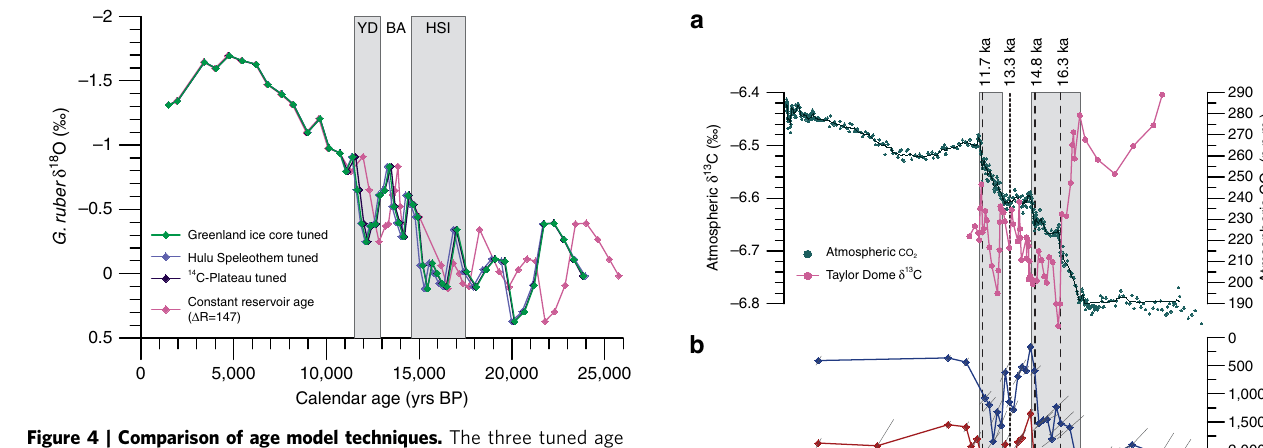
Figure 5 | Radiocarbon records for TR163–23. ( a ) TR163–23 benthic and planktonic D 14 C 0 and atmospheric records of D 14 C. The residual atmospheric D 14 C has been corrected for modelled cosmogenic 14 C production 6 . Benthic and planktonic D 14 C 0 remains relatively constant through deglaciation except for a rapid increase at the end of HS1 and at the end of the BA. The major axis of 1 s error ellipses is plotted for benthic and planktonic D 14 C 0 . ( b ) Conventional radiocarbon ages measured from 31 N. dutertrei , 3 G. ruber , and 25 mixed benthic samples. Deglacial G. ruber and N. dutertrei samples show negligible 14 C offsets. ( c ) Benthic- planktonic 14 C offsets in Galapagos core TR163–23 and Panama Basin core ODP 1240 (ref. 18) indicate similar offsets during the deglacial period. Although TR163–23 B-P offsets show little overall change from the LGM to the Holocene, ODP 1240 suggests a trend of decreasing B-P offsets during this period. One sigma error bars are plotted for B-P offsets. LGM, last glacial maximum. NATURE COMMUNICATIONS|8:14203|DOI: